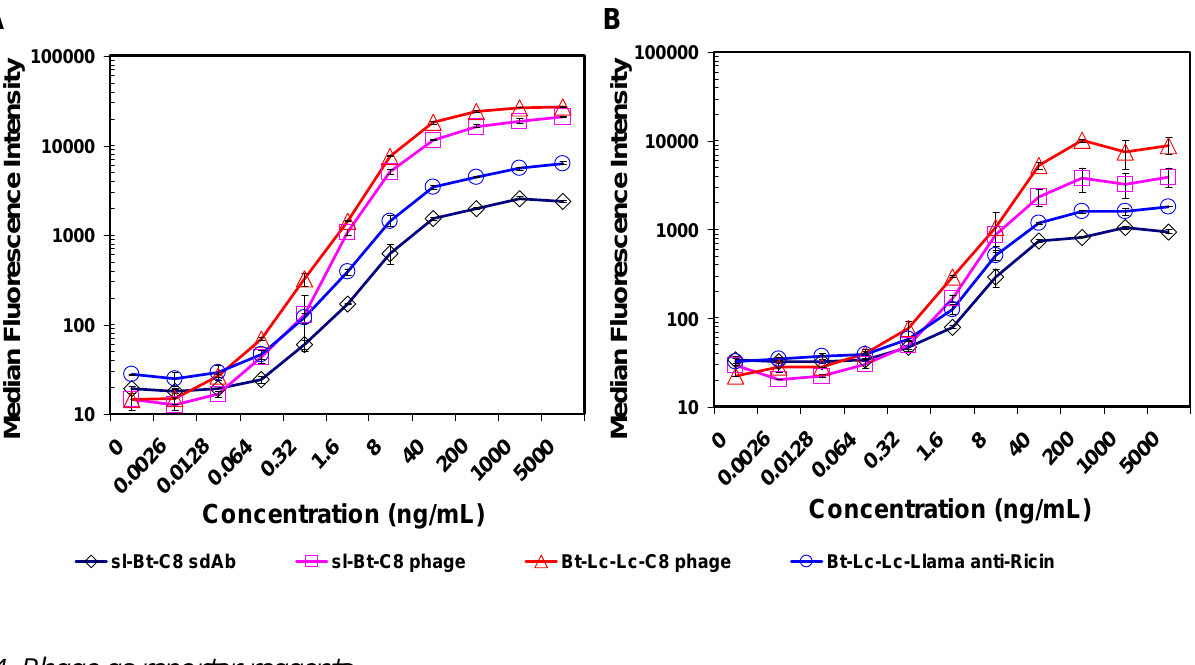
Figure 5 . Luminex detection of ricin using llama polyclonal anti-ricin IgG (panel A) and sdAb F11 (panel B) conjugated to polystyrene beads. The data is plotted as the median fluorescence intensity with the error bars representing the range between duplicate analyses. Results show the enhanced signal generated by using the phage-displayed sdAb as the biotinylated tracer reagent relative to soluble sdAb or conventional